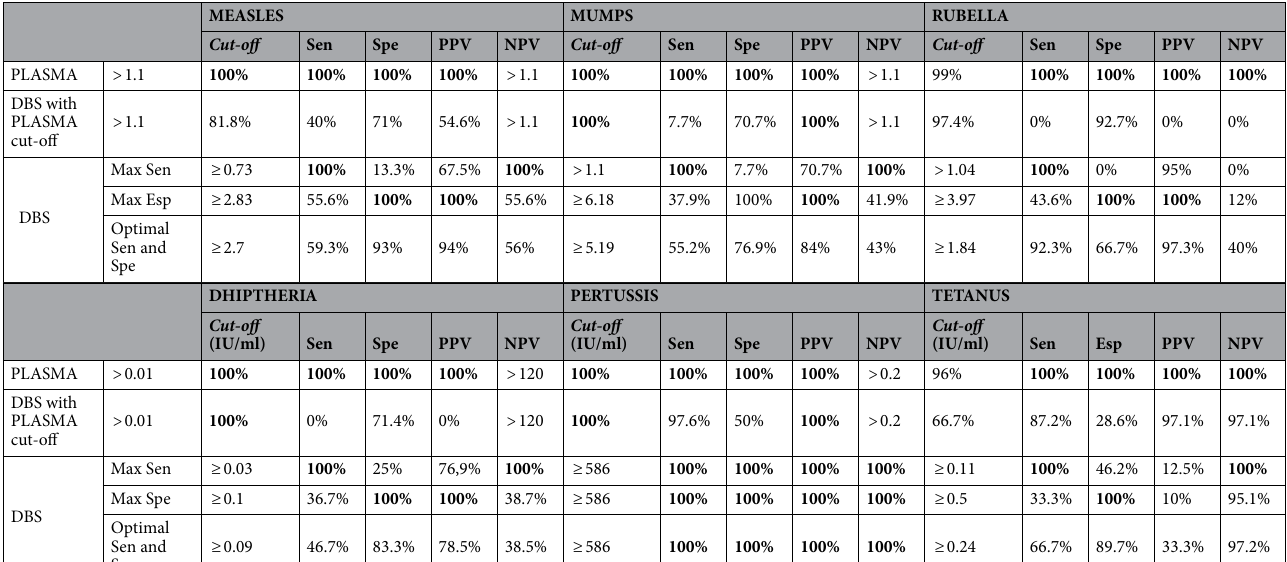
Table 3. Results of VirClia-IgG test for the detection of protective IgG against six pathogens responsible for vaccine-preventable diseases using dried blood samples from 42 paediatric patients. IU International units, ml Millilitre, PPV Positive predictive value, NPV Negative predictive value, DBS Dried blood spots sample, Max Maximum, Sen Sensitivity, Spe Specificity. The cut-offs provided by VIRCELL for plasma have been taken as reference (see Table 1). 100% values are in